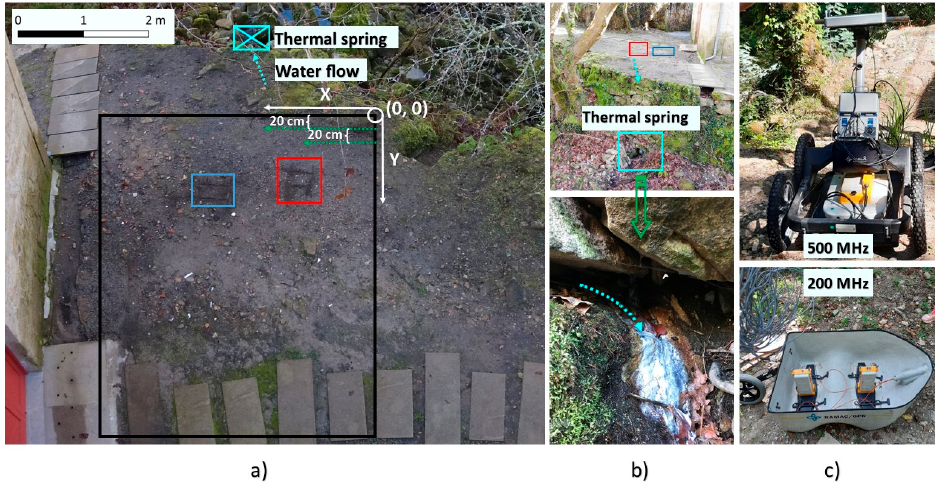
Figure 3. GPR setup: ( a ) 3D grid showing the location of the anomalies identified (red and blue boxes), ( b ) existence of a thermal spring in the area, and ( c ) 500 and 200 MHz antennas used for data collection.